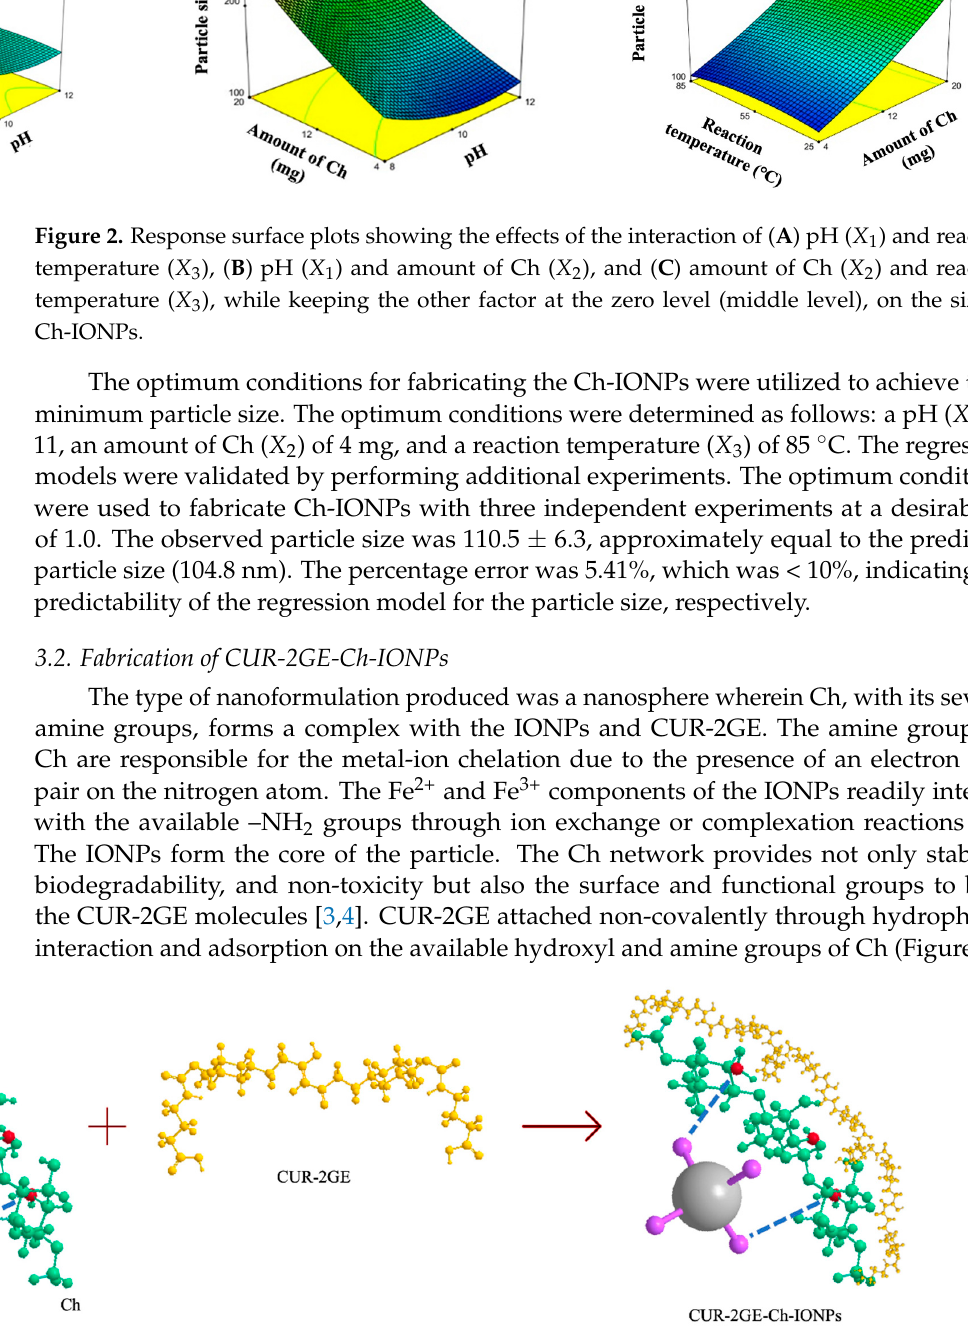
Figure 3. Schematic representation of the fabrication of the CUR-2GE-Ch-IONPs showing the inter- actions among IONPs, Ch, and CUR-2GE.